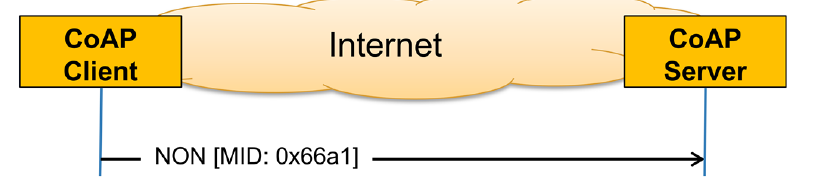
Figure 1. Example of CoAP Non-confirmable Message (NON) exchange. A Message ID (MID) is needed in the header for duplicate